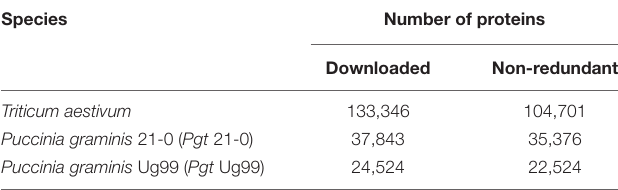
TABLE 1 | Protein datasets used in the